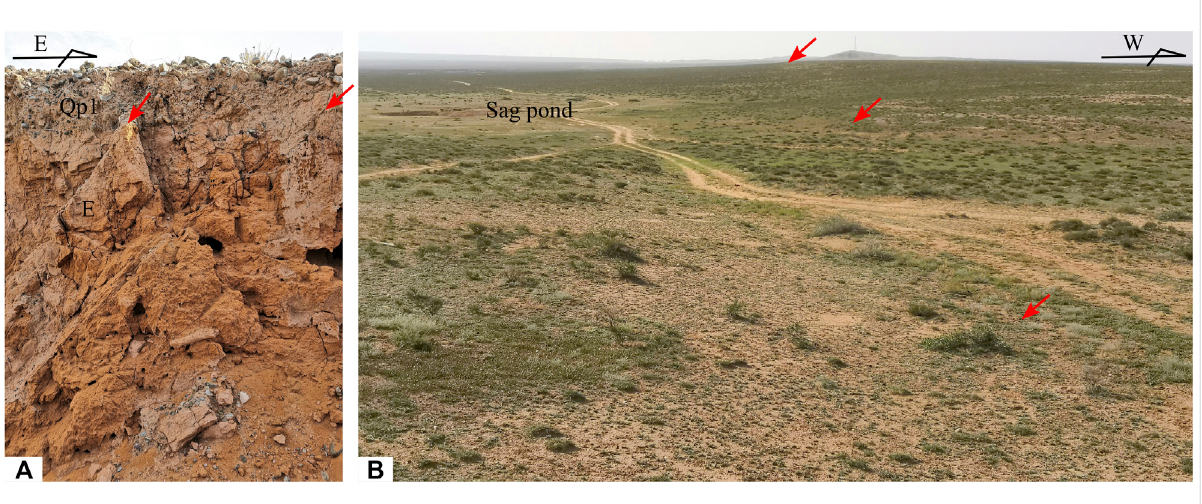
FIGURE 3 Field photos from the site south of Sumutu. (A) Fracture zone. (B) Sag pond and fault scarp. See Figure 2B for